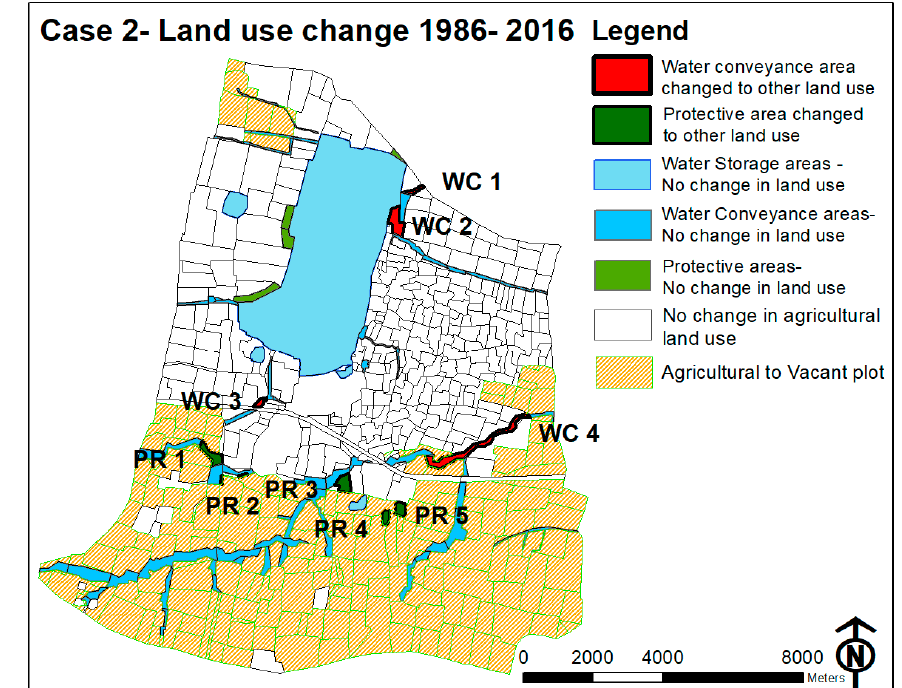
Water 2019 , 11 , x FOR PEER REVIEW Figure 7. Spatial pattern of land use change of common lands in case 1. Figure 7. Spatial pattern of land use change of common lands in case 1.